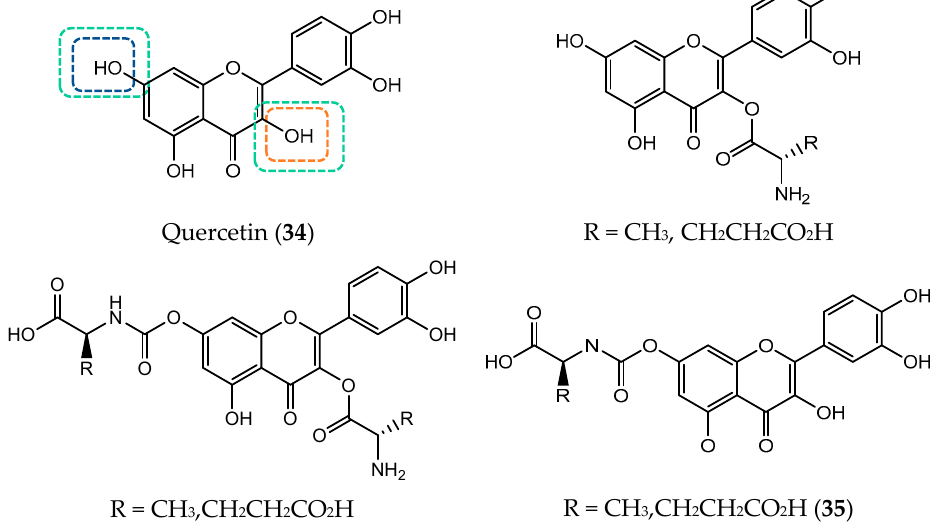
Figure 11. Chemical structure of quercetin ( 34 ) and quercetin-amino acid conjugates with a carbamate and ester linkage.